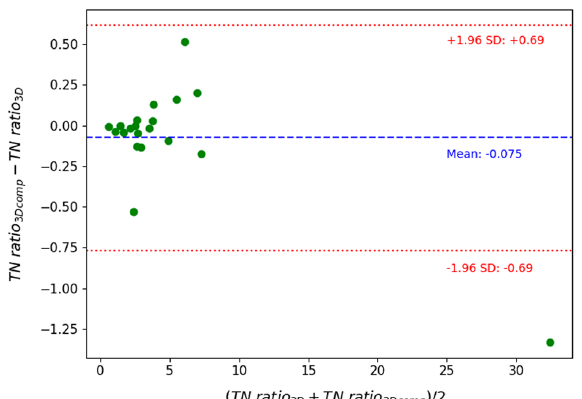
Fig. 5 Bland–Altman plot of the tumor‑to‑normal liver ratio between 3D and 3Dcomp reconstructions for patients for whom lesion contours are available. TN ratio 3D and TN ratio 3Dcomp correspond to the TN ratio estimated from the 3D and 3Dcomp reconstructions, respectively